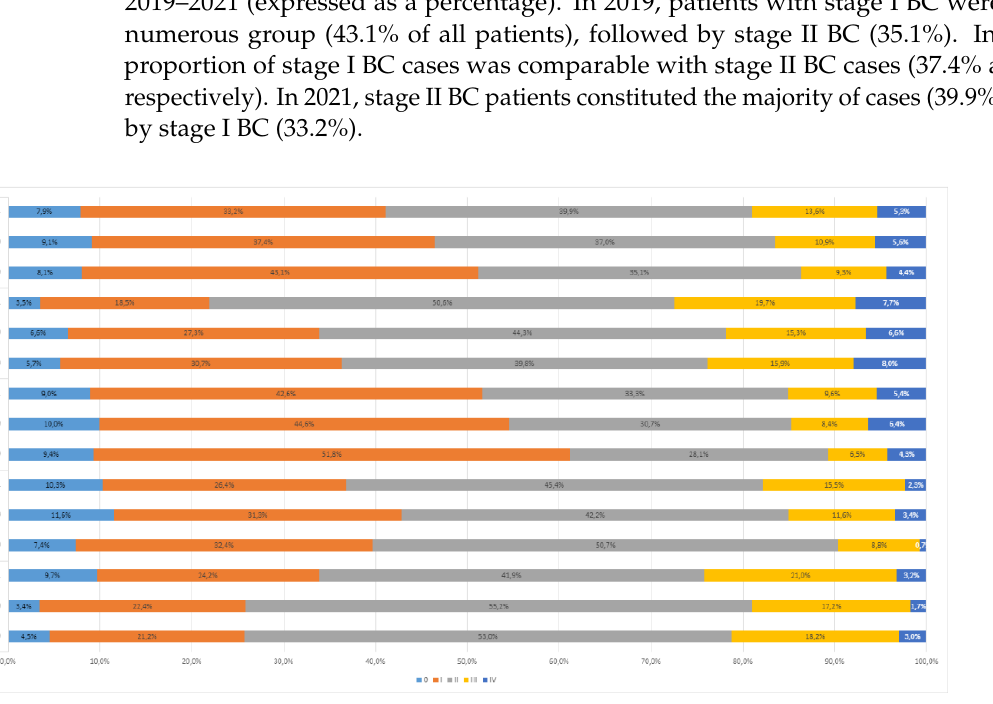
Table 4. Number of cases grouped by age and stage of BC in 2019 – 2021.